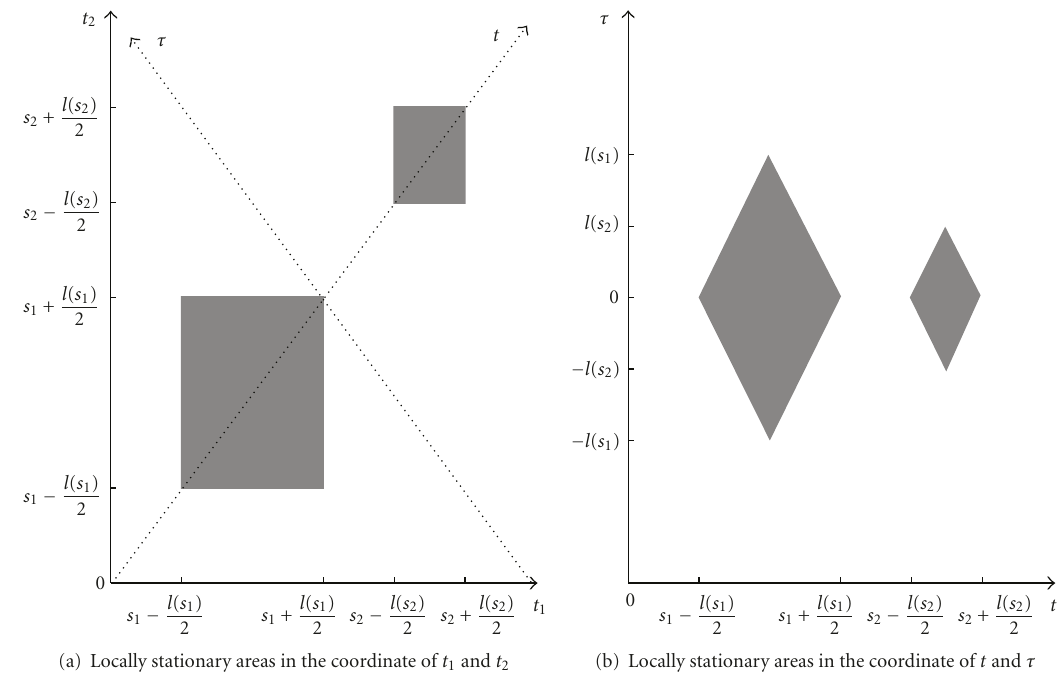
Figure 1: Illustration of examples of locally stationary neighborhoods (a) in the coordinates of two time instants and (b) in the coordinates of the center time location and the time index di ff